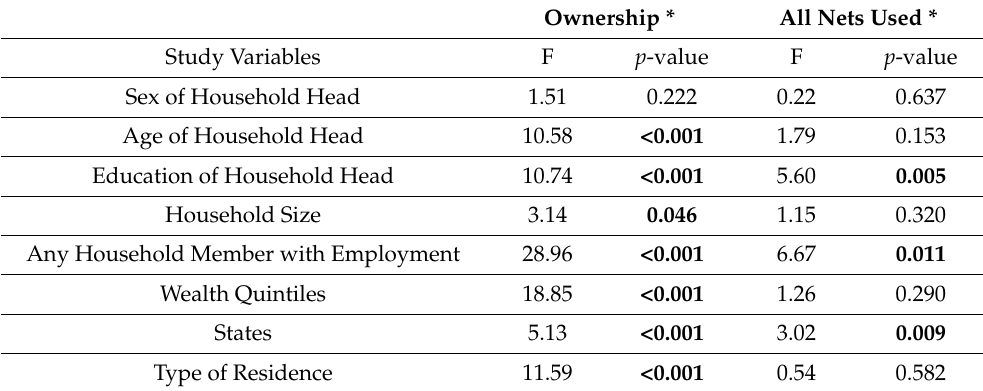
Table 2. Bivariate associations between study variables. * n = 2108 for ownership and n = 1290 for all variables except for education of household head (n = 2096 for ownership, n = 1283 for utilization) and employment (n = 2101 for ownership, n = 1289 for utilization). Notes: Bolded = p -value < 0.05. Ownership * All Nets Used *